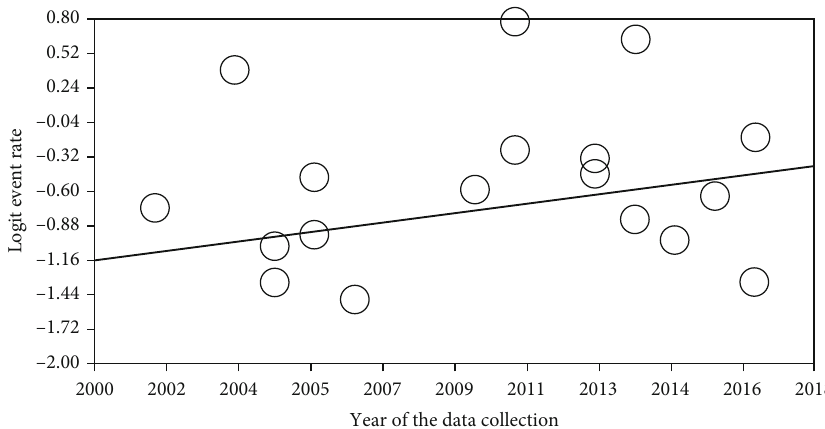
Figure 6: Metaregression of the relationship between the year of study and prevalence of cardiovascular disease in patients with type 2 diabetes mellitus (DM) in Iran.